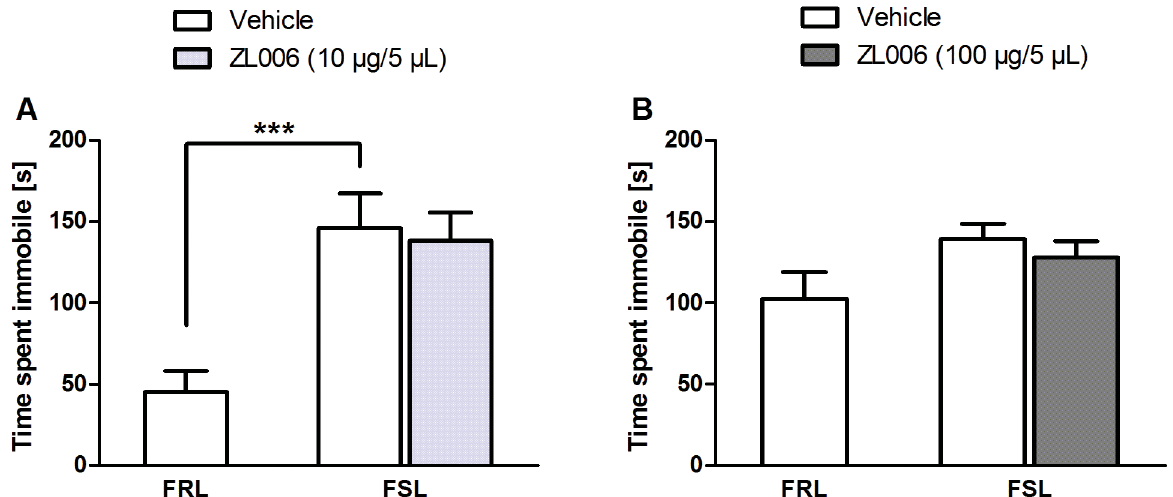
Fig 5. Central effects of ZL006 in Flinders Sensitive/Resistant Line rats. A : Immobilityof Flinders Resistant Line (only received vehicle)and FlindersSensitive Line rats duringa 5-min FST session 25 min followinginfusion of vehicleor ZL006 (10 μ g/5 μ L) at a rate of 2 μ L/min. A significantstrain difference indicatedthat vehicle-treated FSL rats were more immobilethan FRL rats; ** : p (cid:20) .005; n = 5–6/group. B : Replicationof A with a 10 × higherdose (100 μ g/5 μ L). There were no significantstrain or treatment effects, p ’s > .05; n = 8–9/group.Valuesrepresent means ± SEM and were analyzedusing one-wayANOVAs followedby